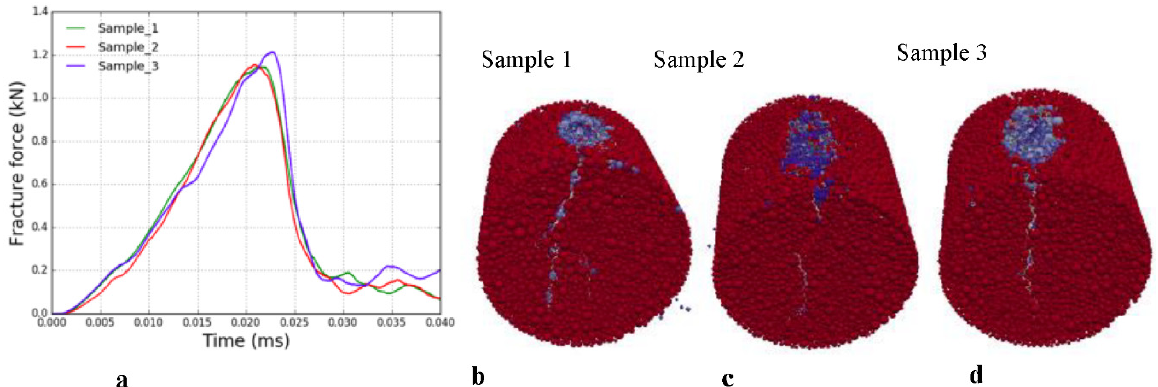
Figure 9. ( a ) Force-time histories of three rock specimens at 0-crack level and ( b – d ) their respective post-process analyses showing the fracture pattern.